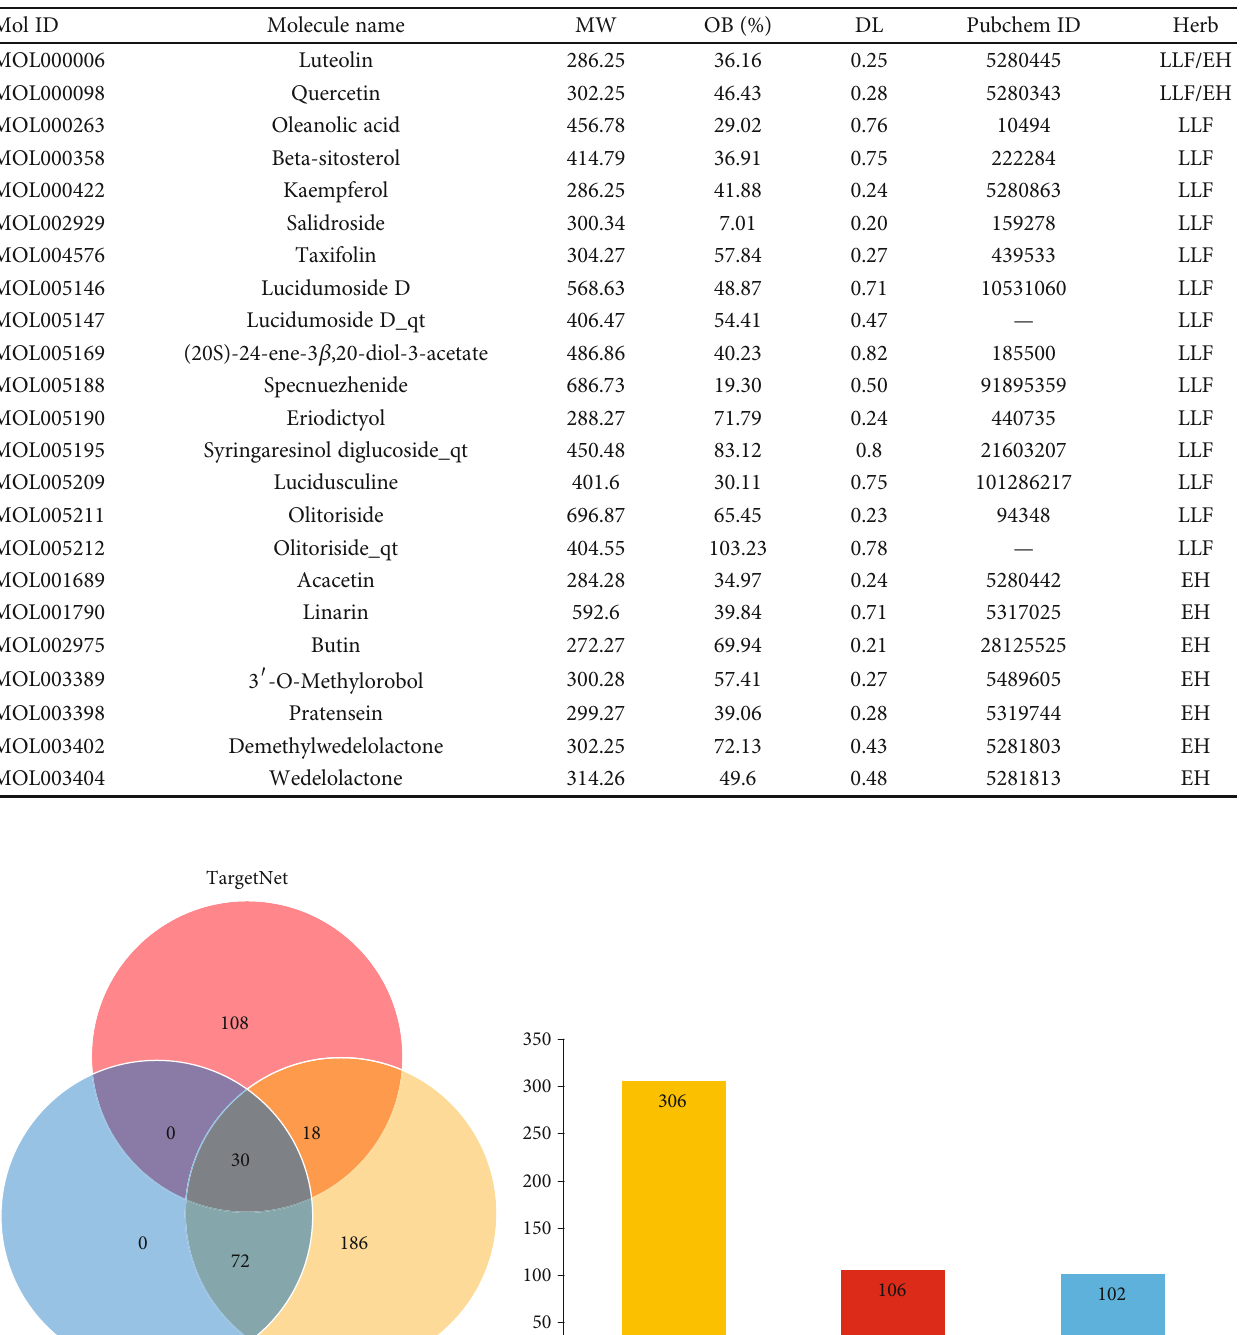
Table 1: A list of bioactive compounds of EZP for network analysis.